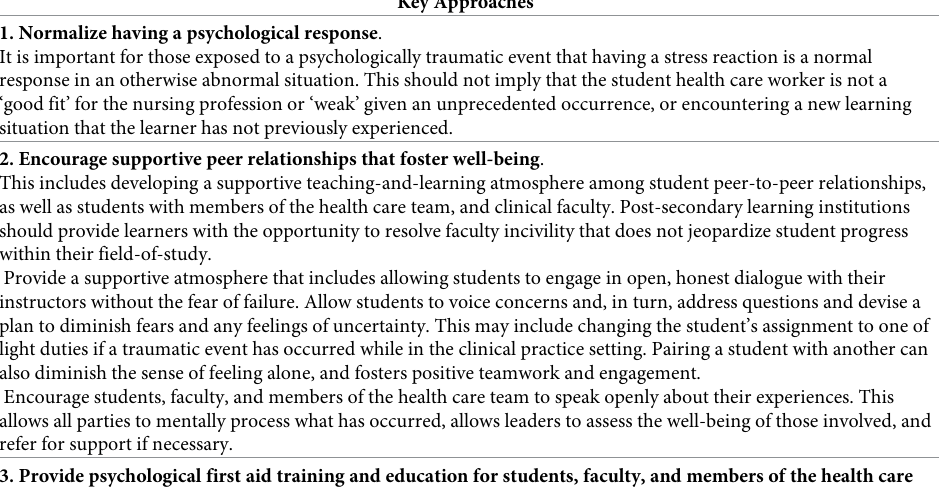
Table 1. Psychological well-being guideline for pre-professional health care students. Key